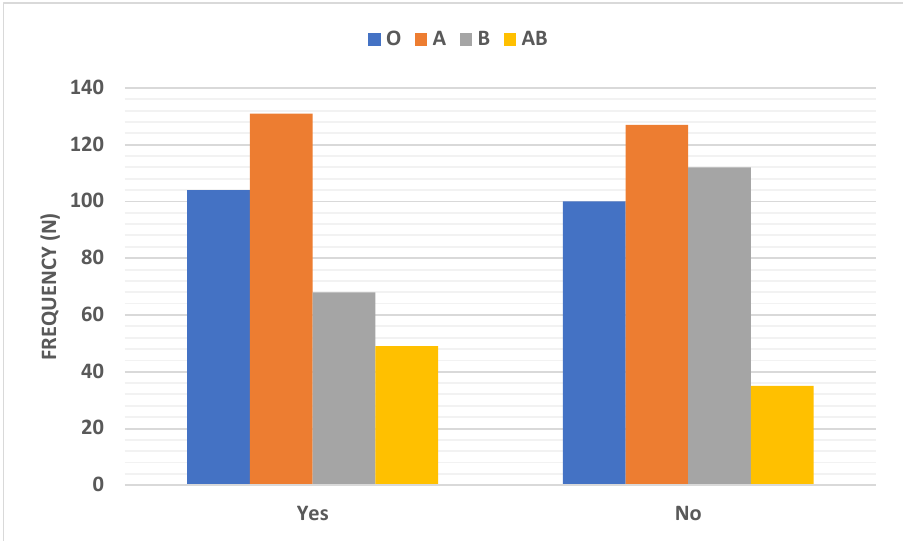
Figure 7. Distribution of myalgia among COVID-19 patients according to the ABO blood group type. Data were presented as frequency (number).